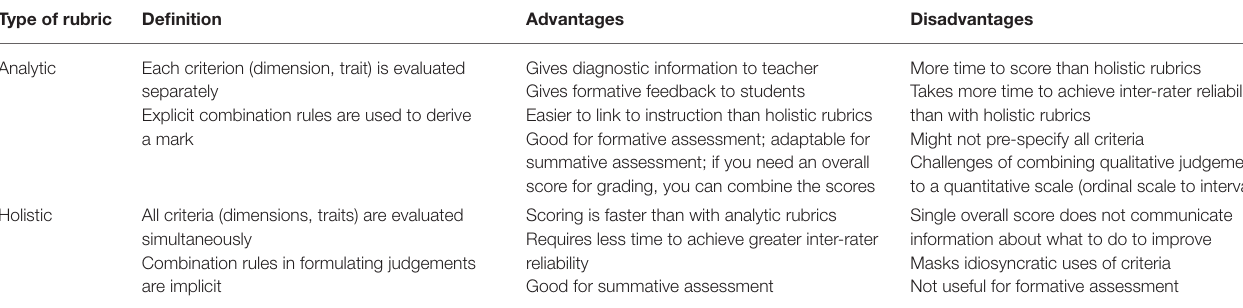
TABLE 1 | Summary of key advantages and disadvantages of different types of rubrics. Type of